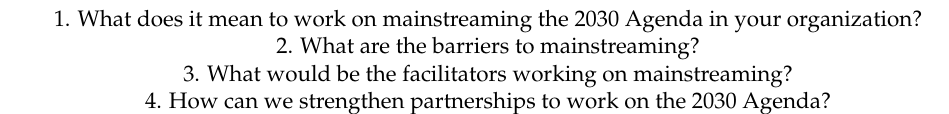
Table A2. Questions asked in the focus